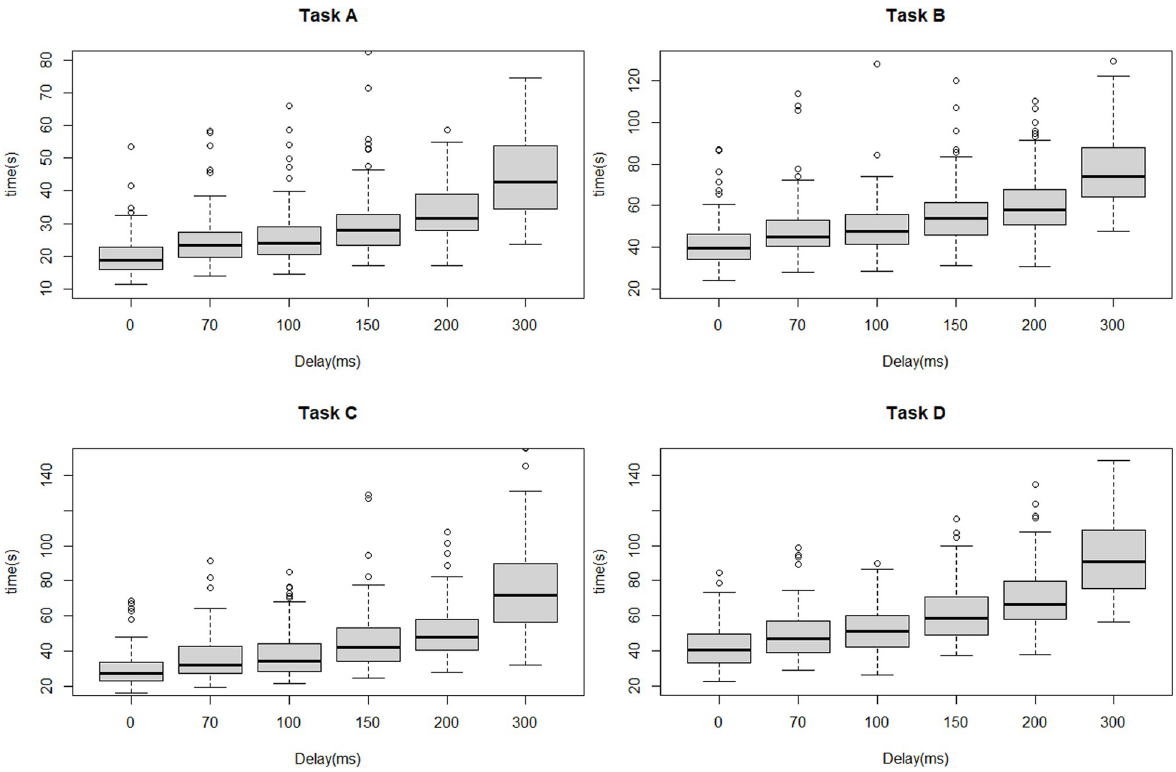
Fig 3. Boxplot of task completion time of each task by all